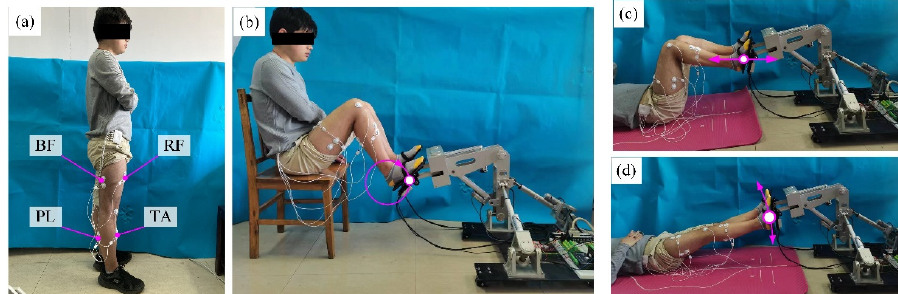
Figure 12. ( a ) Target muscle groups and sensor sticking positions; ( b ) MOTOmed training mode; ( c ) CPM training mode; ( d ) SLR training mode. Table 2. Impedance parameter setting in the 12 groups of experiments.